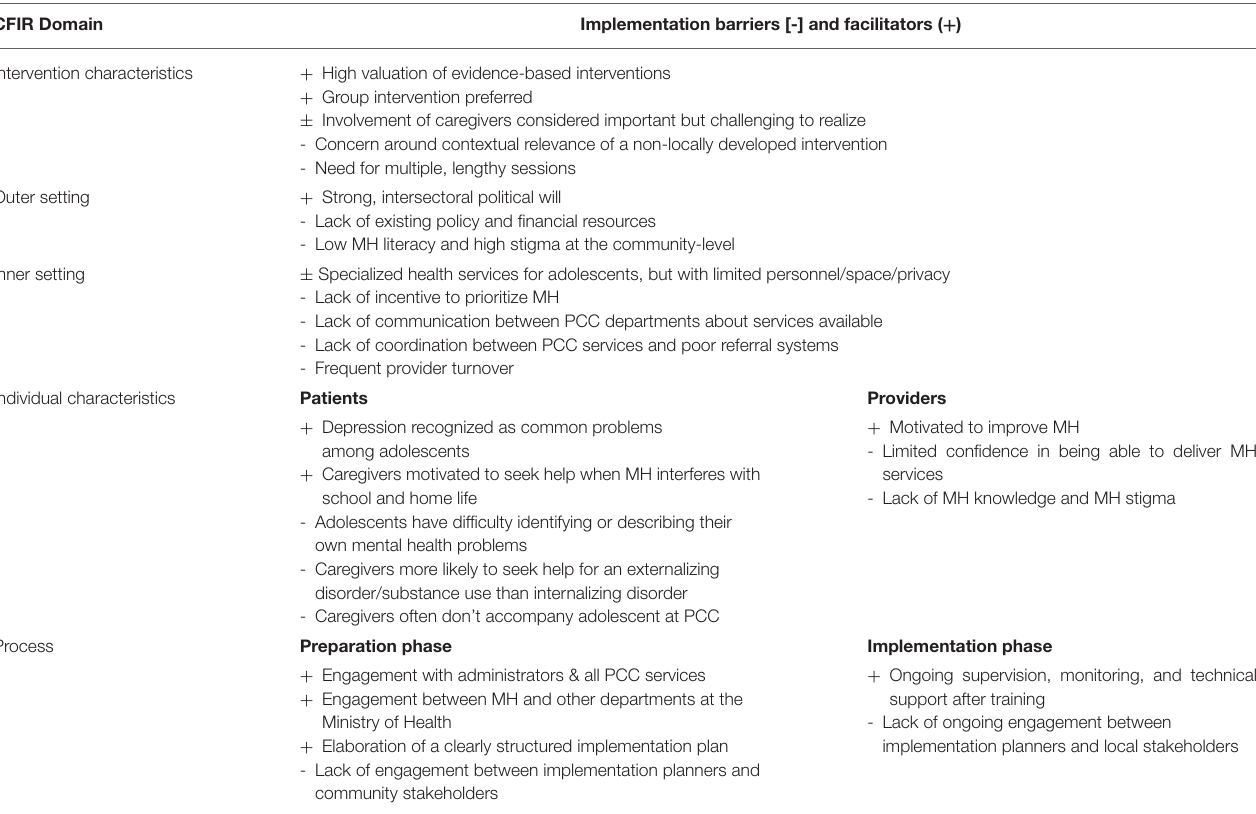
TABLE 2 | Implementation determinants for integrated adolescent depression services in Mozambican primary care. CFIR Domain Implementation barriers [-] and facilitators ( +